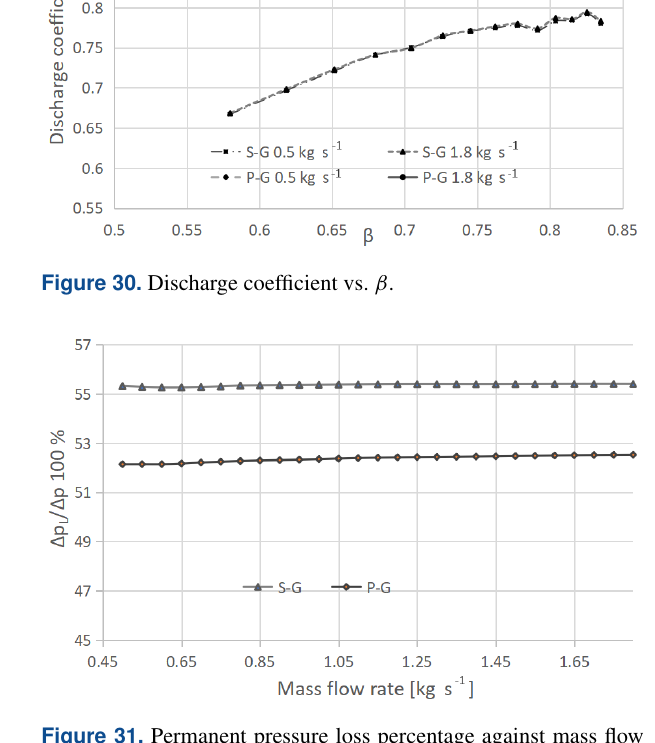
Figure 31. Permanent pressure loss percentage against mass flow rate for both cones, β = 0 .